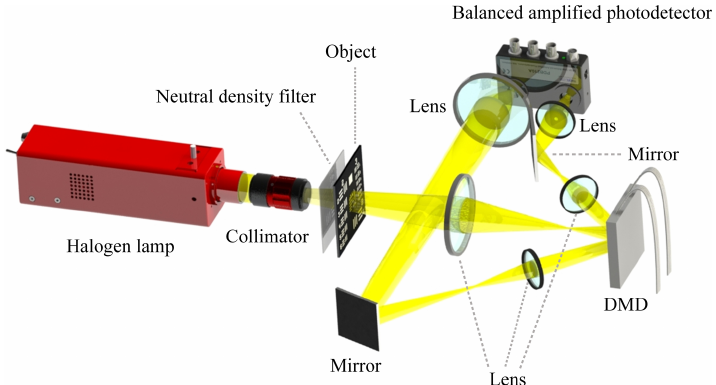
Figure 5. Experimental setup of secondary complementary balancing compressive imaging. DMD: digital micromirror